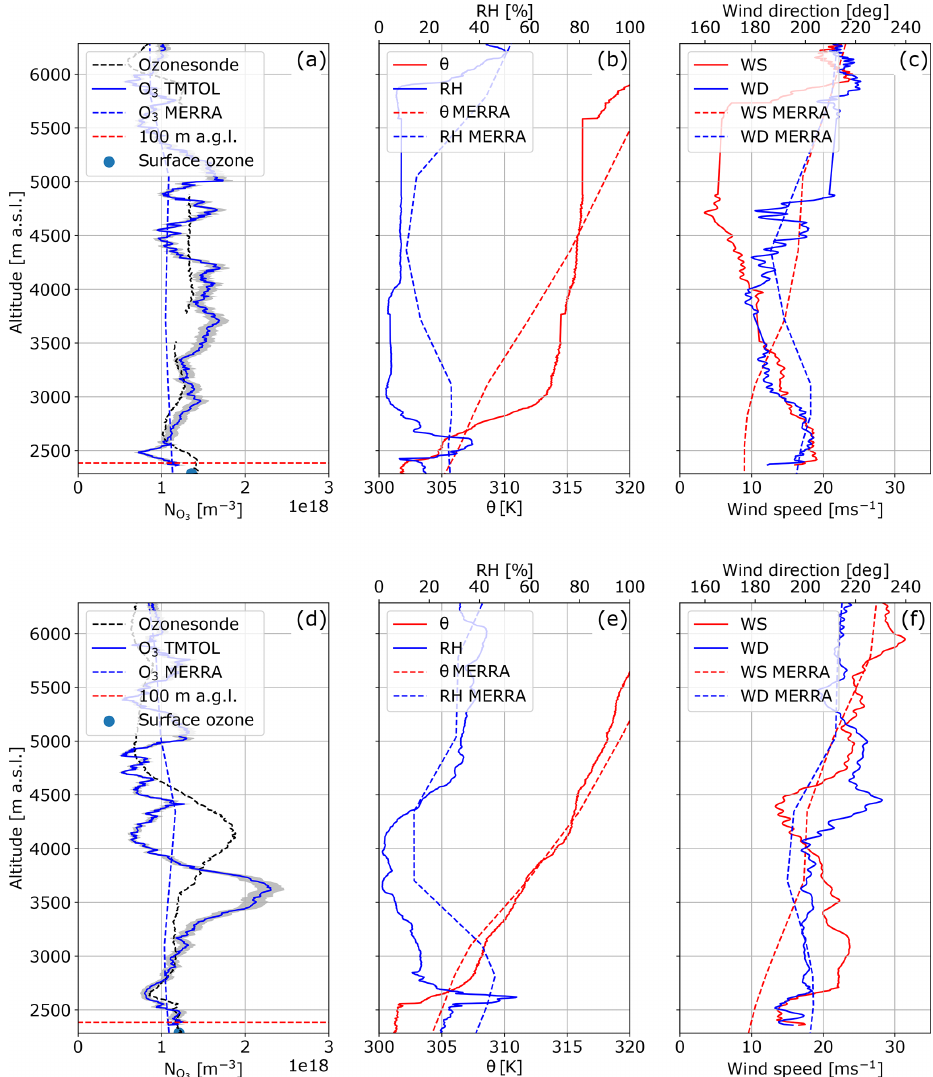
Figure 12. Comparison between the retrieved lidar ozone profile (together with 1 − σ uncertainty), co-located radiosondes, surface ozone meter and MERRA-2 reanalysis at the time of the first (upper row, 04:40UT) and second launch (lower row, 09:10UT). (a, d) Lidar ozone profile (solid, blue), ozonesonde profile (dashed, black), MERRA-2 ozone concentration and surface ozone measurements (light blue). (b, e) Radiosonde potential temperature (solid, red), MERRA-2 potential temperature (dashed, red), radiosonde relative humidity (solid, blue) and MERRA-2 relative humidity (dashed, blue). (c, f) Radiosonde wind speed (solid, red), MERRA-2 wind speed (dashed, red), radiosonde wind direction (solid, blue) and MERRA-2 wind direction (dashed,